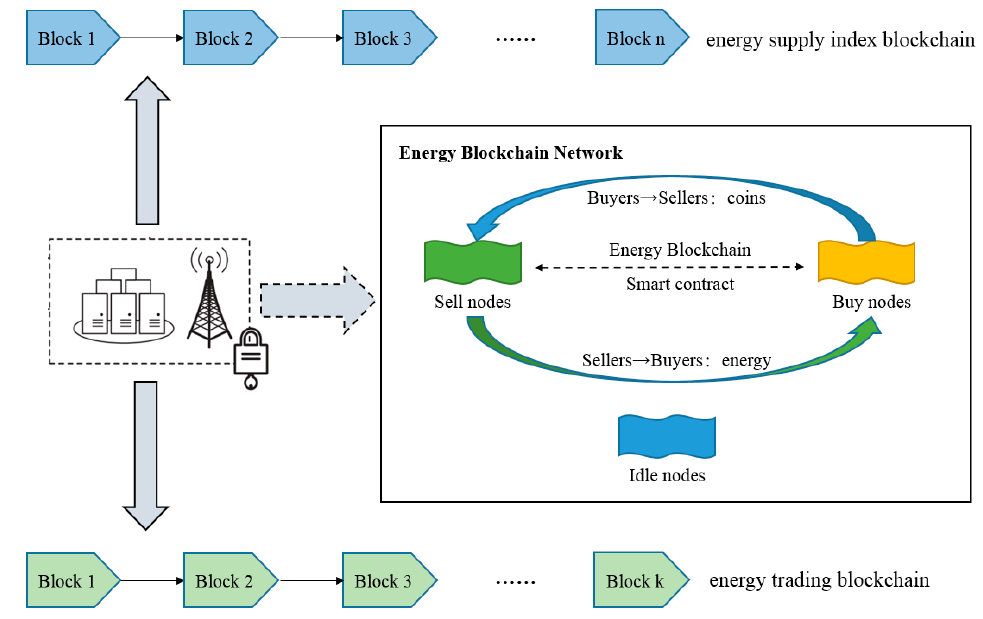
Figure 2. Energy blockchain network.